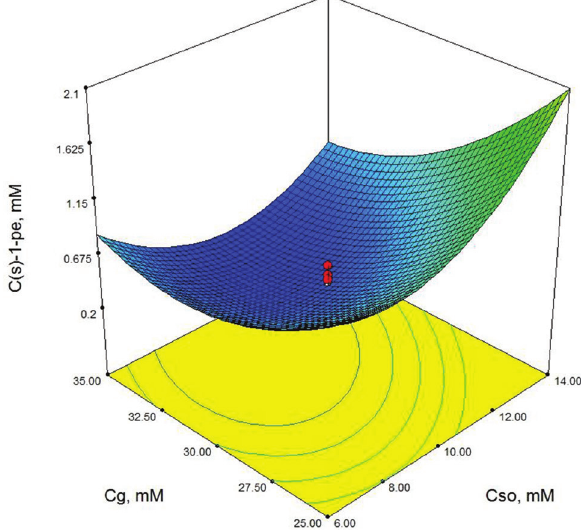
Figure 5: Contour-plot of ( S )-1-phenylethanol concentration: The effect of initial substrate concentration and glucose concentration. Other variable is held at zero level. t = 48 h, C